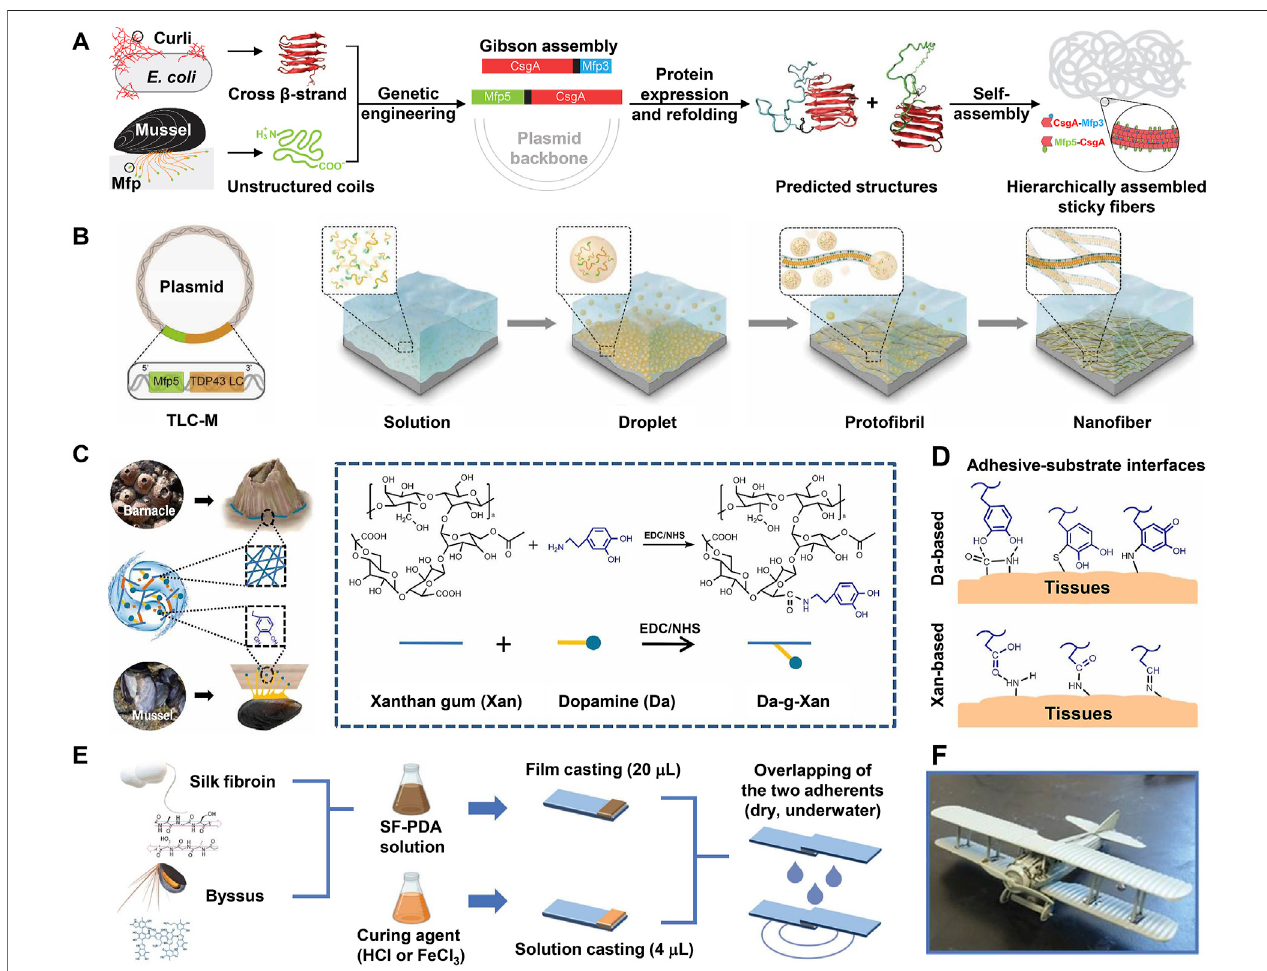
FIGURE 6 | Engineering of BCIAMs based on Dopa-conjugated amyloid structures. (A) Combining csgA of bacteria with Mfp3 and Mfp5 of mussels to engineer multi-proteinself-assembledstickynano fi bers. (B) Engineeringofprotein-basedunderwateradhesivematerialsbypairingalow-complexity(LC)domainofamammalian DNA-binding protein (TDP43) with Mfp5. Exploiting the LC domain, the protein monomers in the solution fi rst undergo LLPS to form condensed droplets, followed by maturation into nano fi bers, and eventually form a stable adhesive layer on the substrate. This mat of nano fi bers shows strong underwater adhesion owing to the large surface area and adhesion property of Mfp5 domains. (C) Design and synthesis of the Da-g-Xan hydrogel adhesive. EDC: 1-ethyl-3-(3-dimethylaminopropyl)- carbodiimide, NHS: N-hydroxysuccinimide. (D) Multiple interfacial linkages between the Da-g-Xan adhesive and tissue surface synergistically mediate strong tissue adhesion. (E) Designandlapshearingtestsofsilk fi broin – polydopamine(SF-PDA)glue. (F) AircraftmodelassembledbySF-PDAadhesive. (A) Adaptedwithpermission from Zhong et al. (2014). Copyright 2014, Nature Publishing Group. (B) Adapted from Cui et al. (2019). (C,D) Adapted from Huang et al. (2021). (E,F) Adapted from Lo Presti et al.